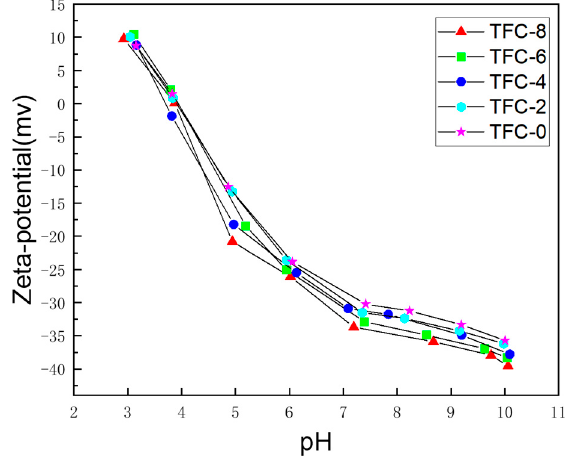
Figure 7. Zeta potential of MPD/TMC composite FO membranes with different concentrations of NaHCO 3 in the aqueous phase.